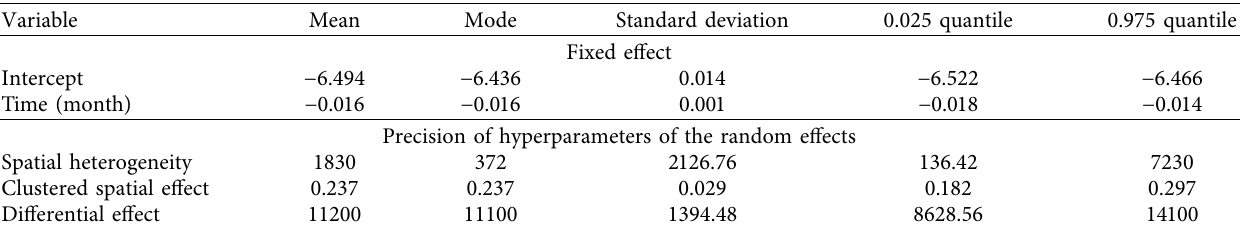
Table 3: Parametric spatiotemporal trends and fixed and precision parameters estimate malaria incidence in northwest Ethiopia between